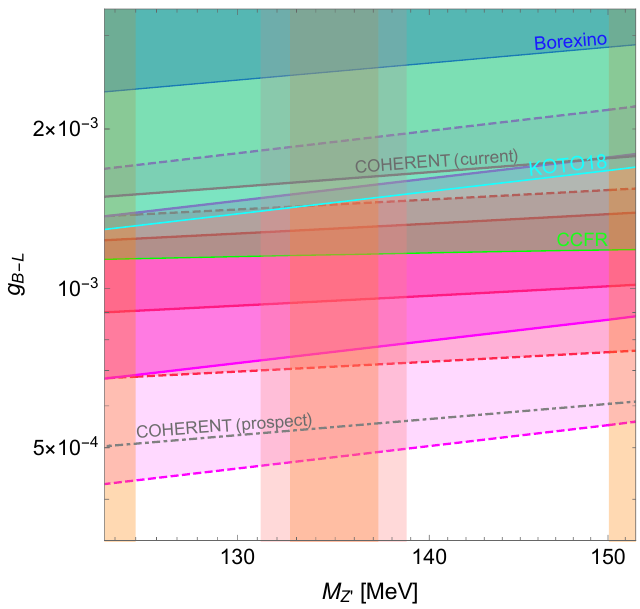
Figure 4 . Parameter space for ( g − 2) µ and KOTO result in the Scenario II, using the benchmark values for ( W u ) 1 i in figure 3. The color manner is the same as in figure 2. In order to specify each band, we change the boundaries for 1 σ and 2 σ to solid and dashed lines,